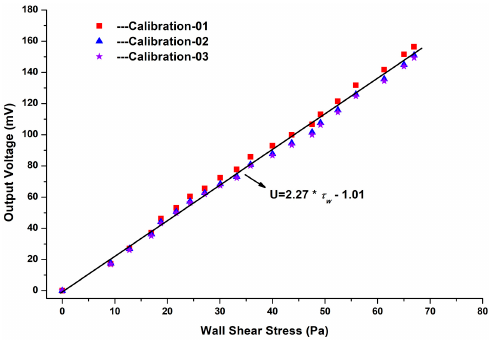
Figure 7. Calibration results of the micro-floating element wall shear stress sensor.